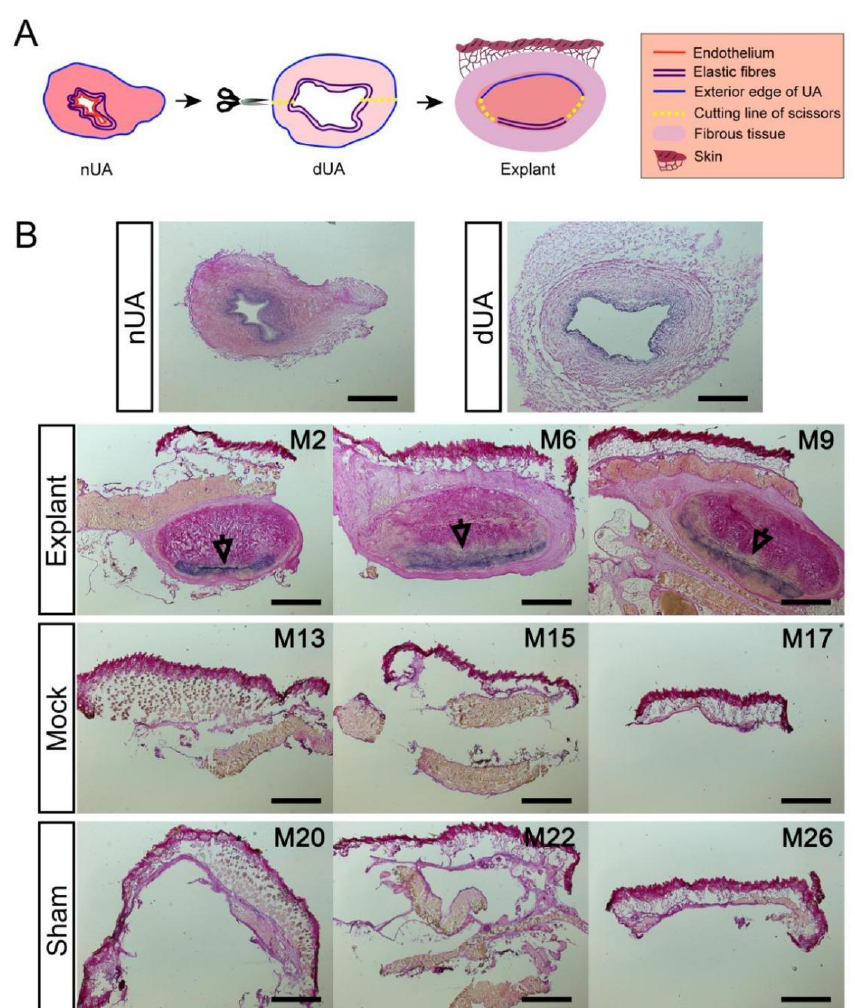
Figure 3. Morphological validation of successful dUA implantation and preservation in explants. ( A ) Schematics of localizing the dUA scaffold in the mouse explant. dUA was cut open into patches and implanted subcutaneously in mice with abluminal side facing the skin of mice. After explantation, the elastic fibres were identified by Miller’s Elastic Van Gieson stain to localise the luminal side of dUA scaffold in explant. ( B ) Miller’s Elastic Van Gieson stain of representative nUA, dUA, and tissue from dUA explant, mock and sham. Dark blue = elastic fibres, pink = mature collagen, yellow = red blood cells, muscle, and other tissues. M2/6/9 and similar present the numbering of mouse individuals. The luminal side of nUA and dUA shows the dark blue stained elastic fibres that were preserved. All dUA scaffolds in the explant displayed a layer of elastic fibres (marked by black arrows) distal to the skin, showing the same direction as they were implanted. No dUA scaffolds are found in tissue from mock and sham groups. Scale bars = 1 mm.